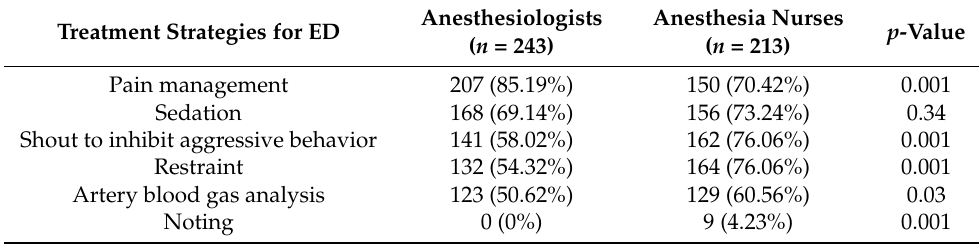
Table 4. Reported therapy strategies.